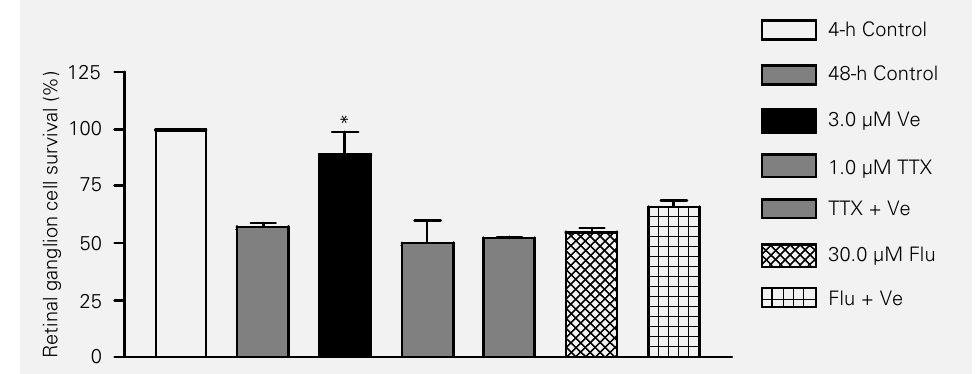
Figure 2 - The effect of veratri- dine (Ve) (3.0 µM) was inhibited by 30.0 µM flunarizine (Flu) and 1.0 µM tetrodotoxin (TTX). Data are reported as mean ± SEM of three different experiments, each performed with at least three different dishes. *P<0.001 compared to the 48-h control (ANOVA followed by the Newman-Keuls test).